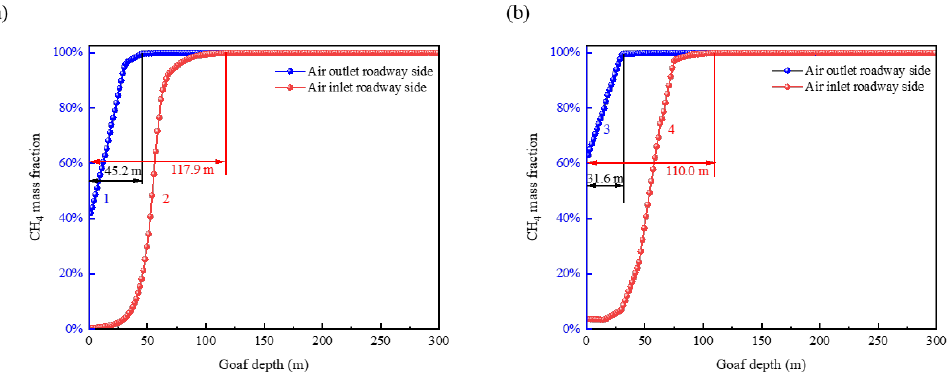
Figure 11. Comparison diagram of gas mass fraction change curve at the side of air inlet roadway and air outlet roadway in the control group ( a ) caving zone and ( b ) fracture zone.